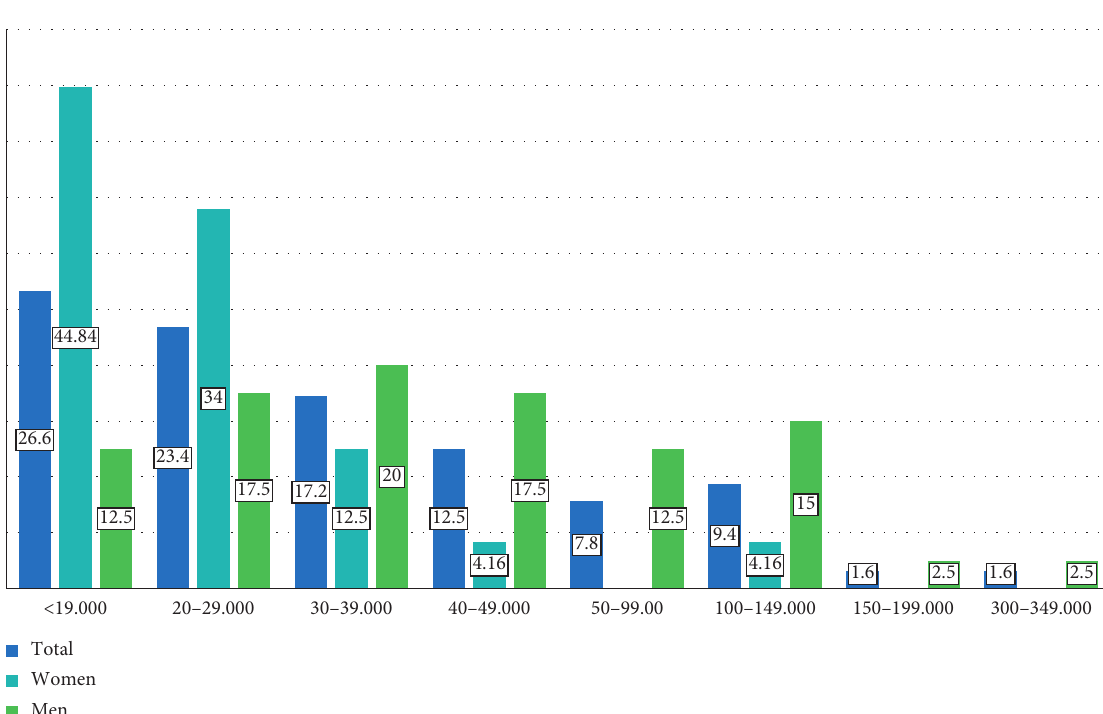
Figure 4: Annual